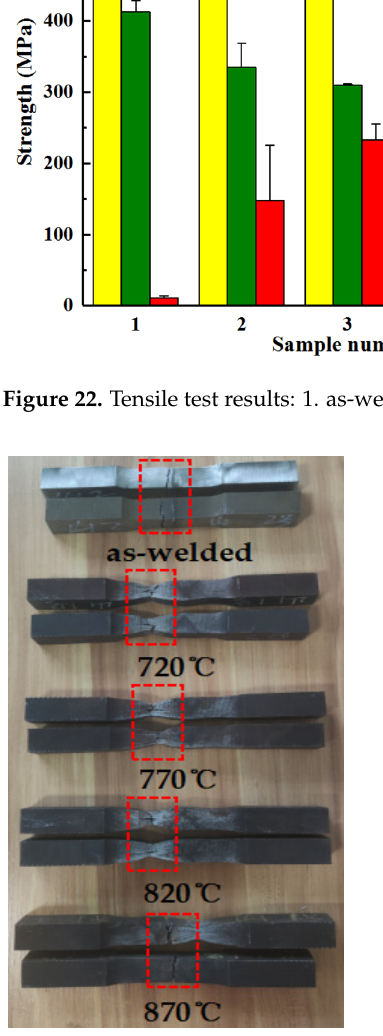
Figure 24. Bending result diagram . Figure 25(1–5) illustrate the SEM morphology of tensile fracture of S11306 ferritic stainless steel welded joints after different heat treatment temperatures. It can be seen that the fracture surface without heat treatment after welding shows a very small number of dimple features, while the rest are cleavage features. Combined with Figure 10(1), there are a large number of martensite structures in the weld zone, but the plasticity of marten- site is poor, which leads to brittle fracture of the specimen. The fracture position is at the weld zone, corresponding to the result obtained by stretching. When the heat treatment temperature is 720 °C, it can be seen from Figure 12(2) that although there is more mar- tensite in the base metal zone, the ferrite grain size tends to be uniform, so the dimples increase with deeper holes, and the fracture shown equiaxed dimples plus quasi-cleavage, which belongs to ductile-brittle fracture. At 770 and 820 °C, the number of dimples at the fracture reaches the maximum value. From Figure 12(3,4), it can be seen that martensite hardly existed in the base metal zone, the toughness of the base metal increases, and the